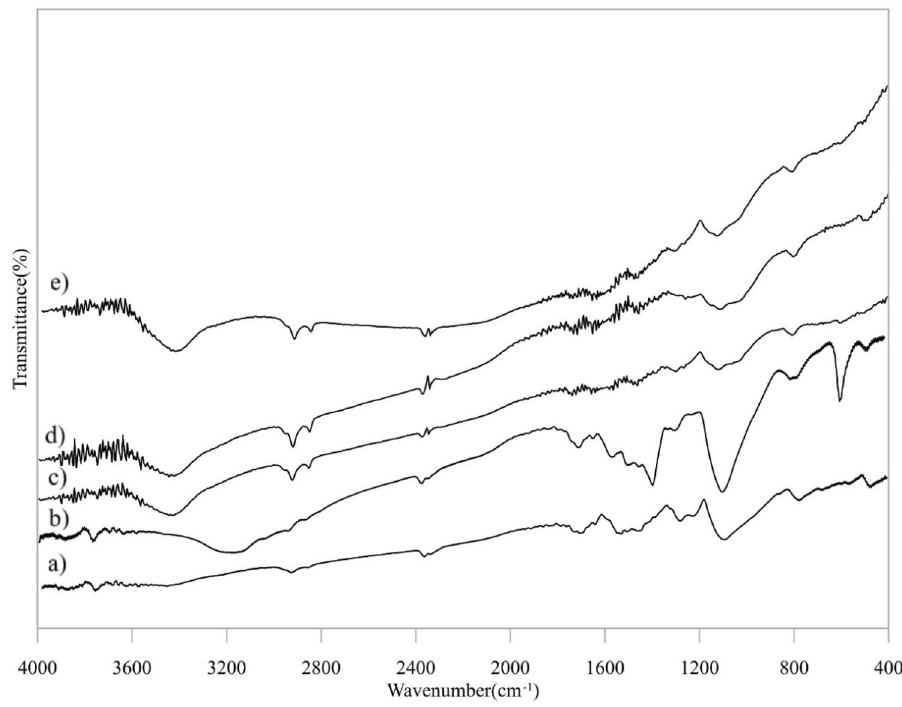
Fig. 2 FTIR spectra of PANI and PANI/GNS nanocompos- ites: a 0.5 wt% GNS, b 0 wt% GNS, c 2.5 wt% GNS, d 5 wt% GNS, e 10 wt%